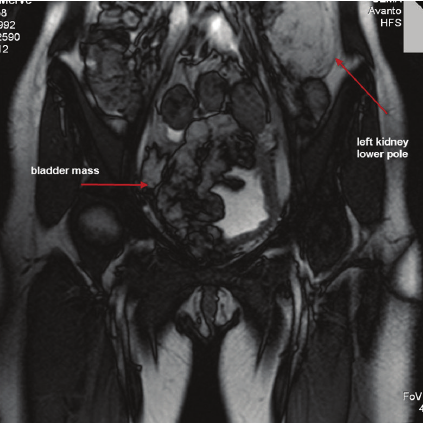
Figure 1: Coronal image showing a multilobulated mass lesion, arising from the right and superior walls of the bladder, largely extended in right half of the pelvis is observed. Figure 2: Angiomyolipoma showing hyperintensities compatible